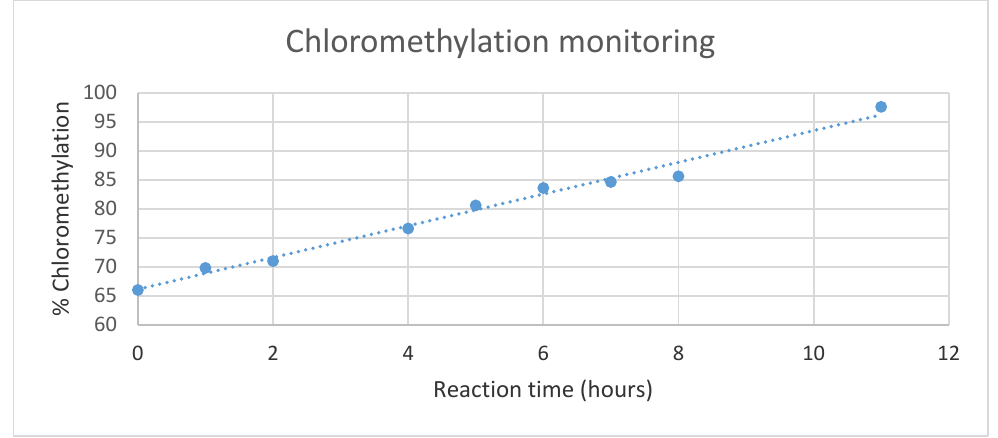
Figure 3. Chloromethylation degree variation versus reaction time.